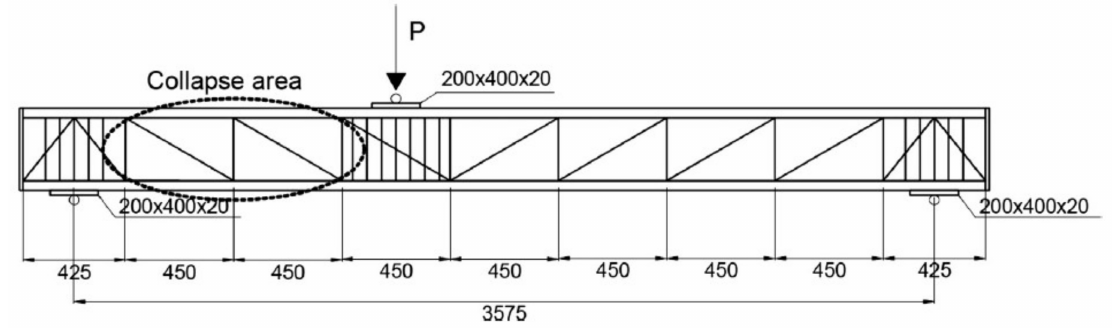
Figure 16. Geometry of the beam and load condition (Chisari and Amadio [16]).